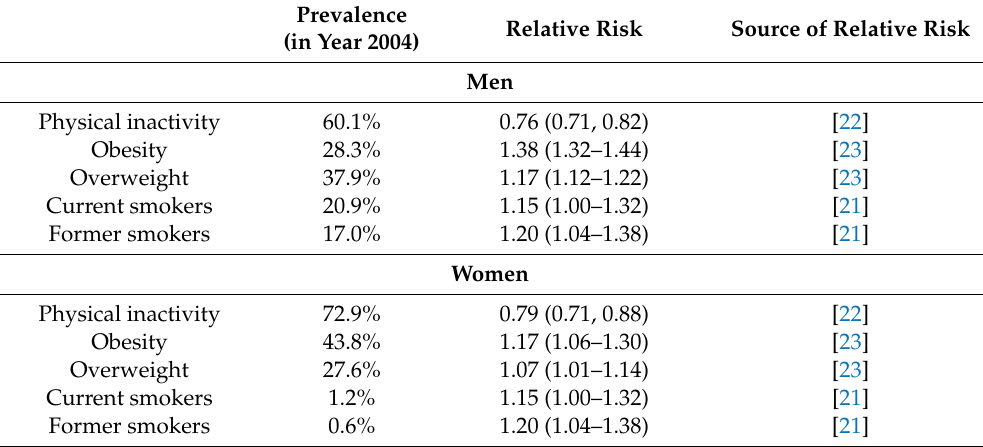
Table 1. Prevalence and relative risk estimates for the selected risk